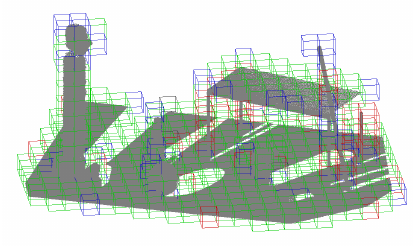
Figure 8: Geometric features of the voxel cells